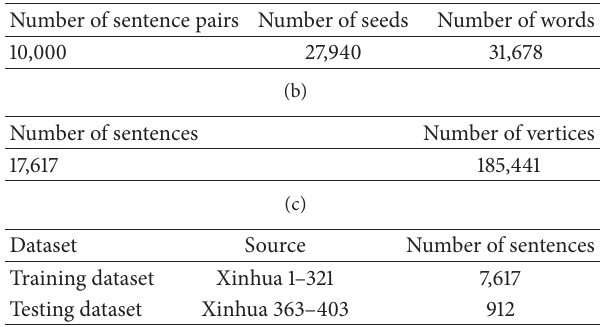
Table 4: (a)English-Chineseparallel corpus. (b)Graph instance. (c) Chinese unlabeled dataset: CTB7